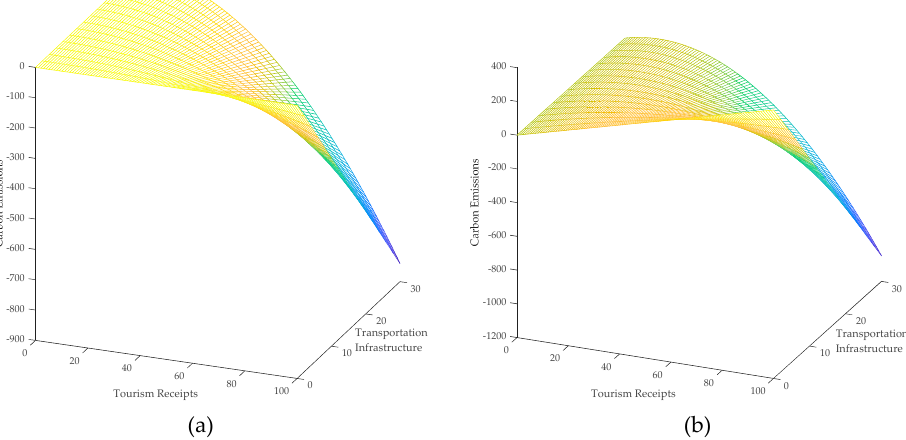
Figure 5. ( a ) Direct and ( b ) indirect effect of tourism on carbon emissions using transportation infrastructure as the moderator.